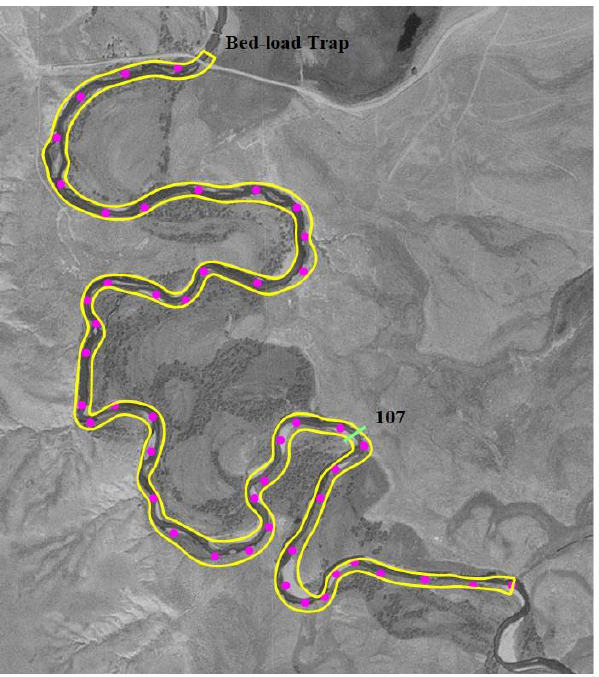
Figure 6. Selected reach of East Fork River. Solid circles represent the approximate locations of bed samples.